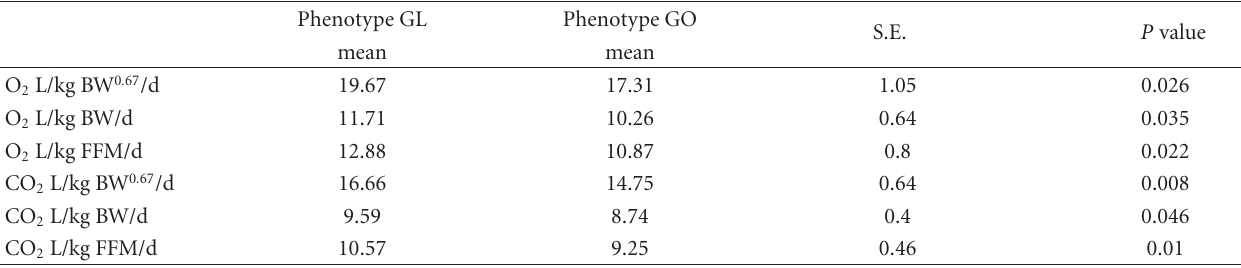
Table 3: Di ff erences between both phenotypes estimated with a linear mixed model approach (group means and standard errors of the estimated e ff ect due to phenotype; GL: lean phenotype, GO: overweight